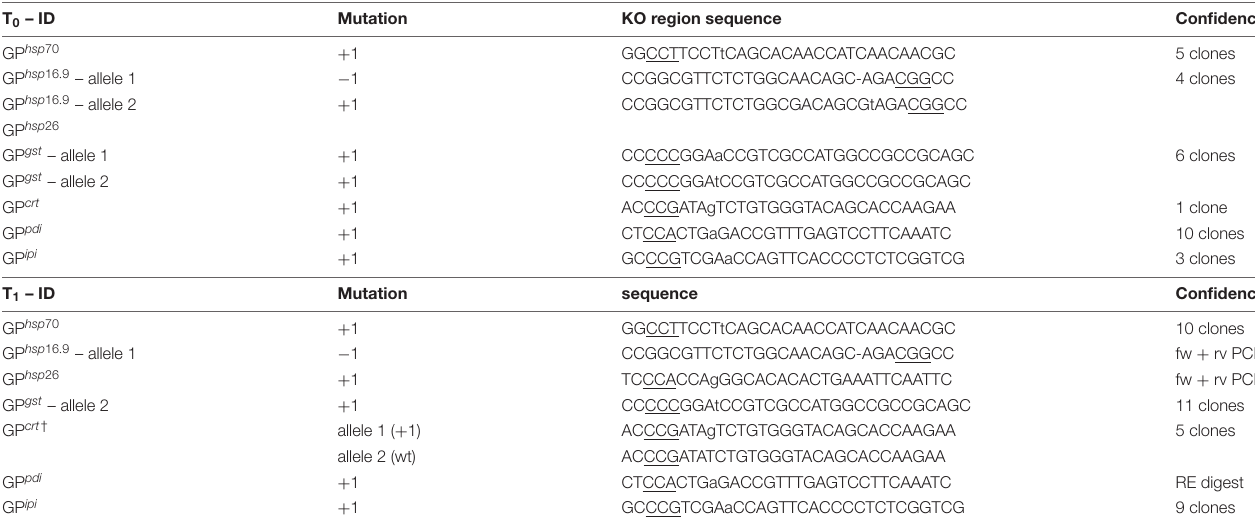
TABLE 1 | Selected knockout mutants obtained with